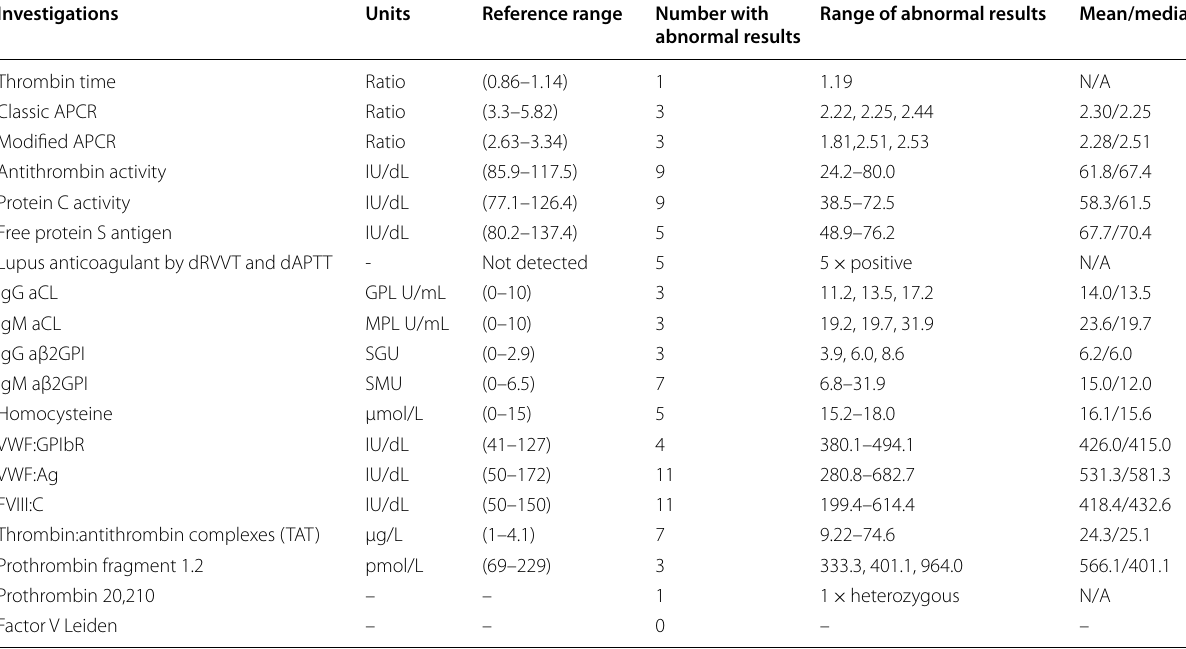
Table 2 Summary of measurements at baseline (pre-CRRT)